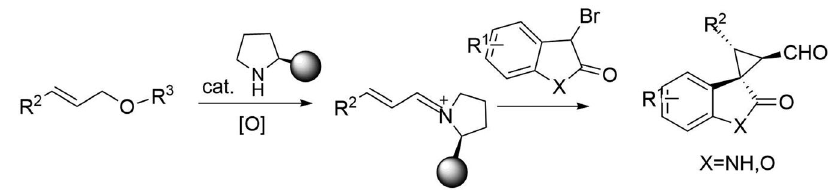
Fig. 1 Oxidative iminium-ion activation. A strategic approach to amino catalysis using ethers as substrates envisaged in this paper.